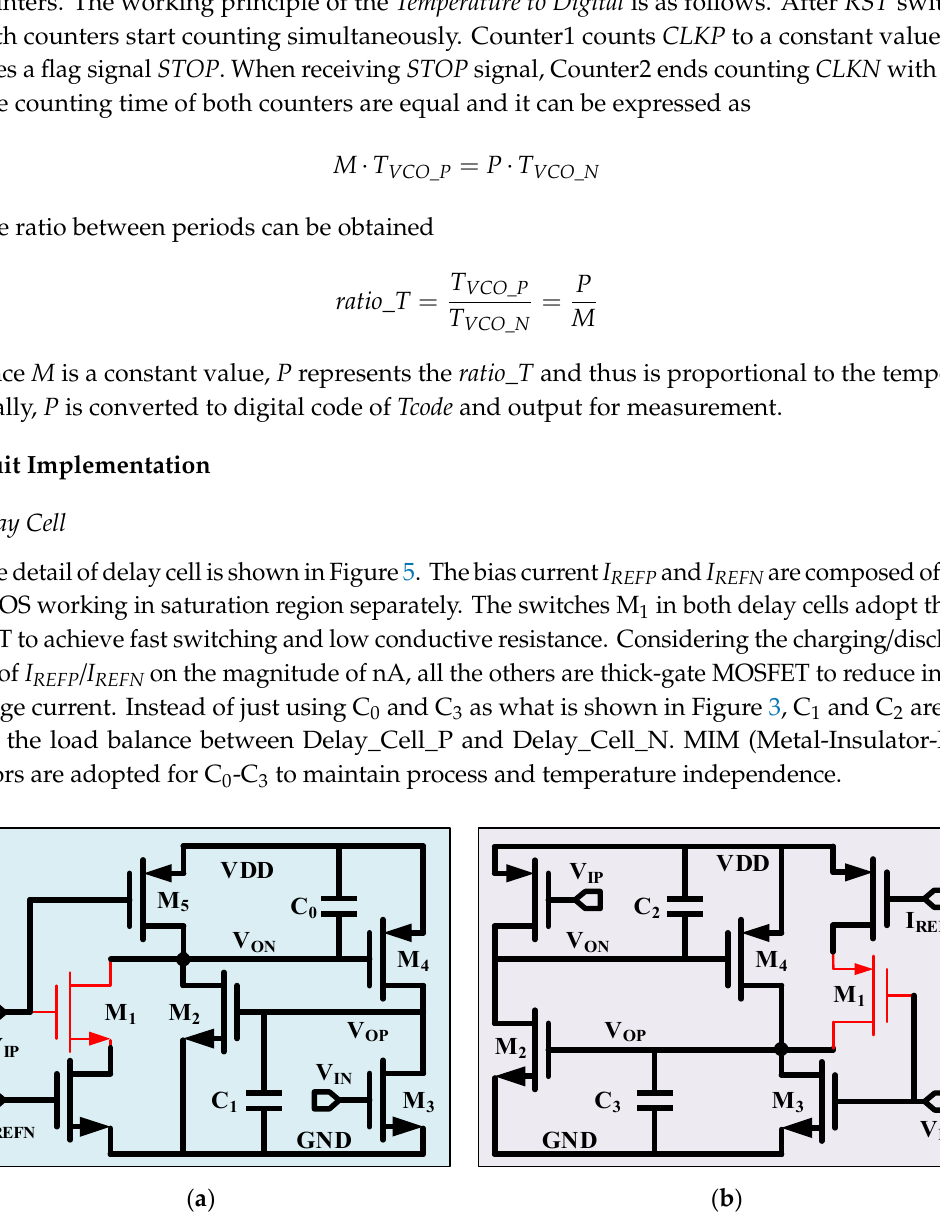
Figure 4. Block diagram of the temperature sensor.